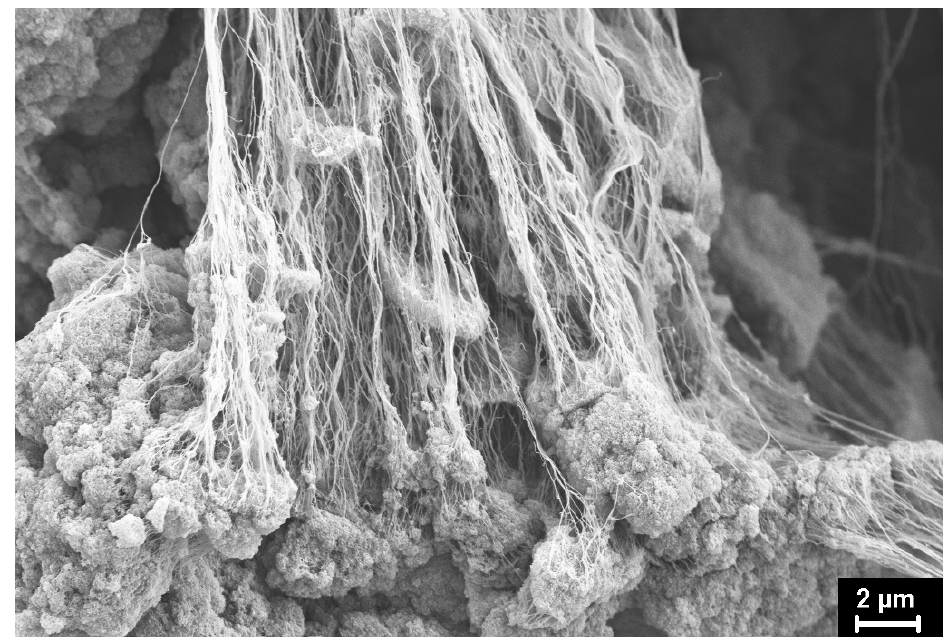
Figure 14. SEM micrograph of SC reactor powder (other location).